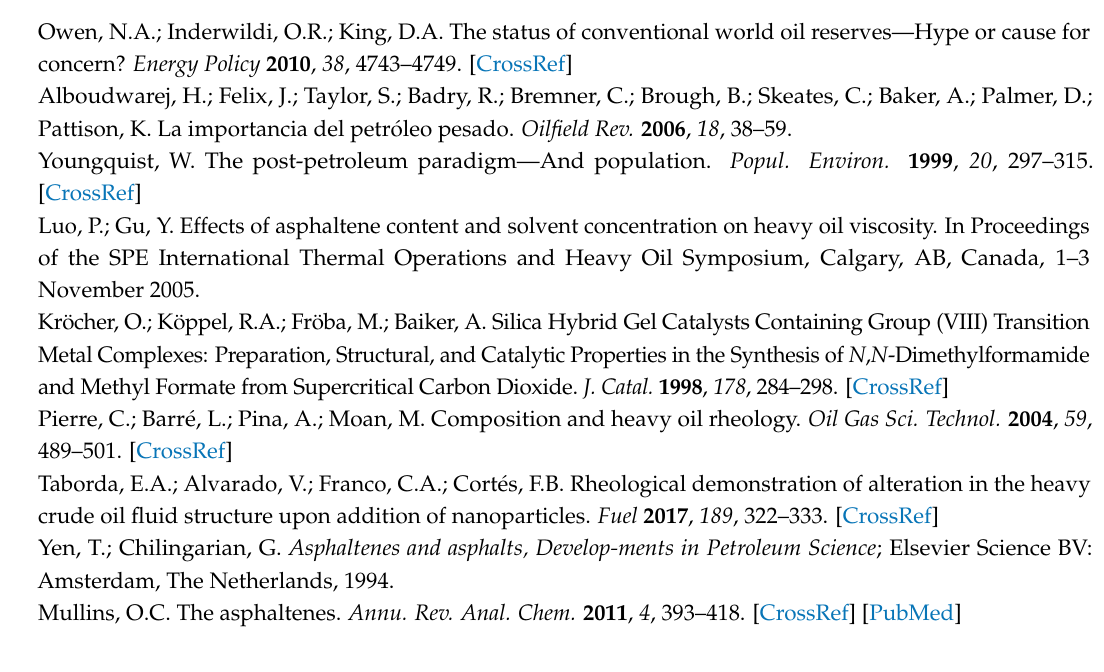
s1, Figure S1. Calibration curve obtained for the EHO asphaltenes in toluene solutions, Figure S2. FTIR analysis for S9, S11 and S66 nanoparticles, Figure S3. The visual appearance of (a) the carrier fluid and (b) the nanofluid, Figure S4. Rheological behavior evaluated for the EHO with a dosage of 5 vol % of xylene with plate-plate and cone-plate geometries at 30 ◦ C, Figure S5. Asphaltenes adsorption isotherms performed for S9, S11 and S66 nanoparticles, Figure S6. Rheological behavior of an extra-heavy oil (EHO) in the absence and presence of 1000 mg · L − 1 of SiO 2 nanoparticles with different mean particle sizes of 9 (S9), 11 (S11), and 66 nm (S66) at 30 ◦ C. The symbols are experimental data, and the continuous lines are from the Carreau model, Figure S7. Hysteresis behavior at 30 ◦ C for an extra-heavy oil in the presence of 5 vol % of a) the carrier fluid composed of a xylene/dimethylformamide ratio of 0.2, and b) the nanofluid with S9 nanoparticles at 1000 mg · L − 1 composed by the carrier fluid. The symbols are experimental data, and the continuous lines are from the Carreau model, Table S1. SLE parameters for the obtained adsorption